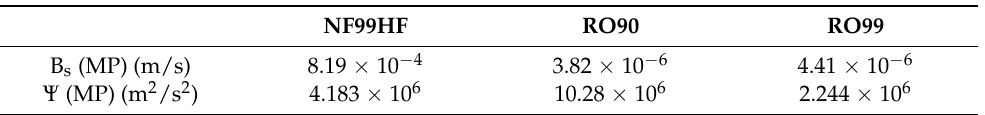
Table 5. Solute permeability coefficients and Ψ parameters for the different membranes obtained using the solution-diffusion model in the removal of methyl paraben.